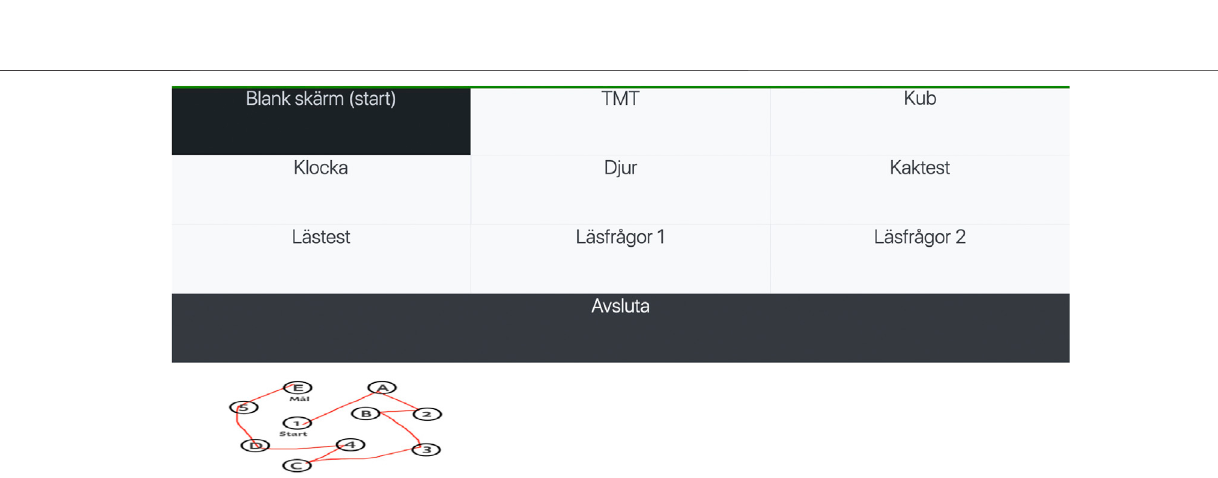
FIGURE 3 | The interface used to set up the iPhones before a data capturing session. Here one can set the IP address and an identifying name of the phone. Furthermore one can select which data streams to